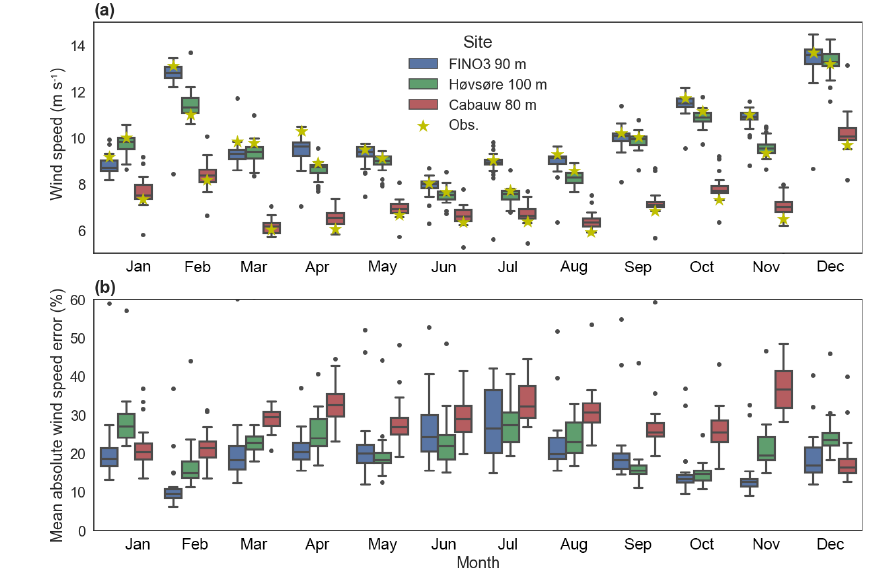
Figure 6. (a) Monthly distributions of mean wind speed for the MMs (box plots) and observations (star) at each location (colors). (b) Monthly distributions of the models for the mean absolute error (MAE) for wind speed at each location (colors). The boxes represent the second and third quartiles. The whiskers extend to the smallest (bottom) or largest (top) value that is within 1.5 times the inter-quartile range. Samples outside this range are shown as outliers.